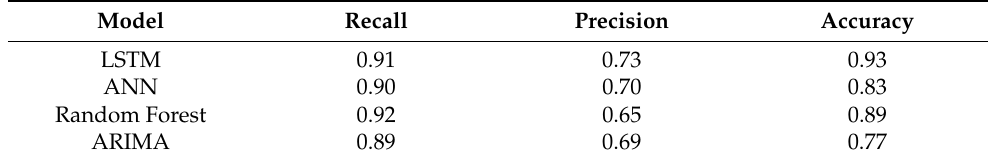
Table 8. Result of model